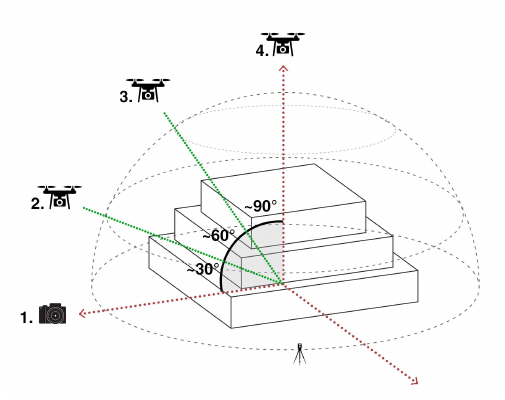
Figure 5. Typical camera standpoints for the photogrammetric data